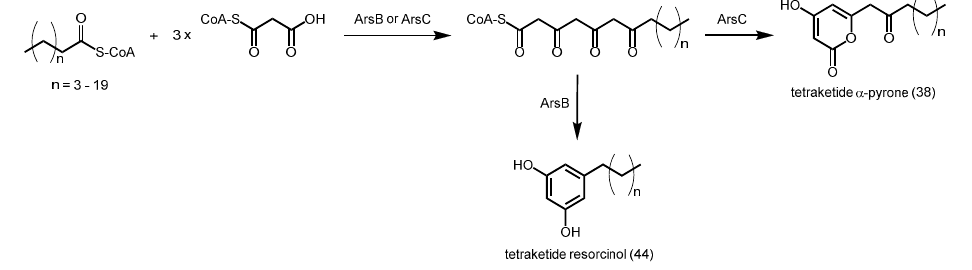
Figure 13. Active site cavity of ArsC-WT (blue, PDB ID: 3VS8) and ArsC-G284W mutant (pink, PDB